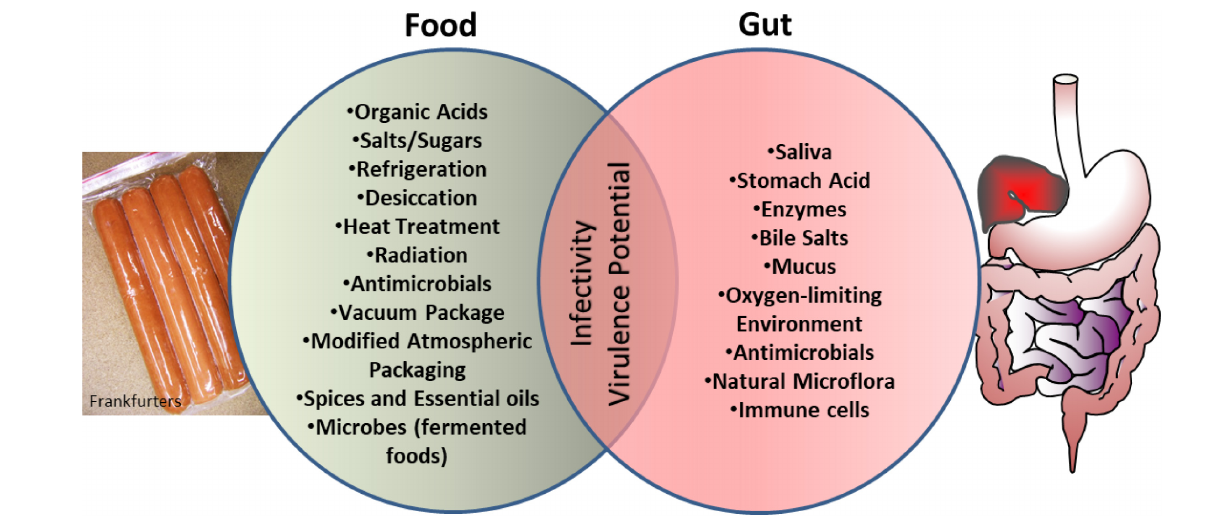
Frontiers in Microbiology |